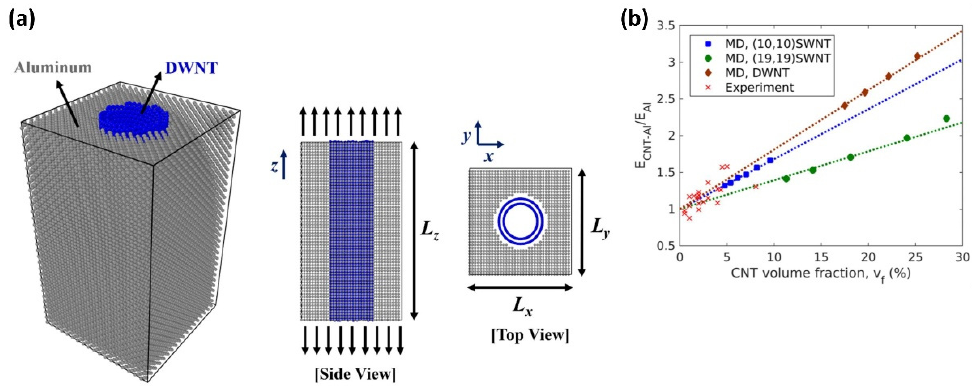
Figure 9. ( a ) CNT–Al composite in representative volume elements for the MD simulations. Lz = 124.44 Å and Lz = 97.25 Å for DWNT-Al and SWNT-Al, respectively. Lx and Ly were adjusted from 44.5 to 89.1 Å according to the CNT volume fraction and CNT size; ( b ) the variation of Young’s moduli of CNT–Al composites with CNT volume fractions [67].